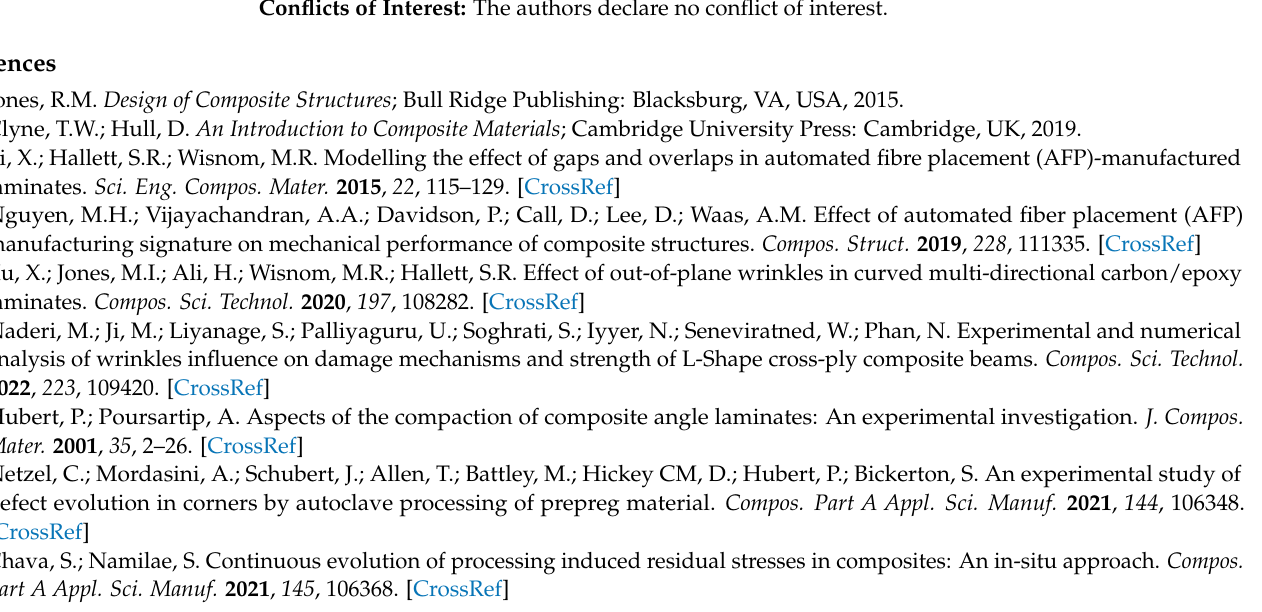
pressed horizontally by a factor of five to make deformations more clearly visible. ( a ) Gap. ( b ) Lap.